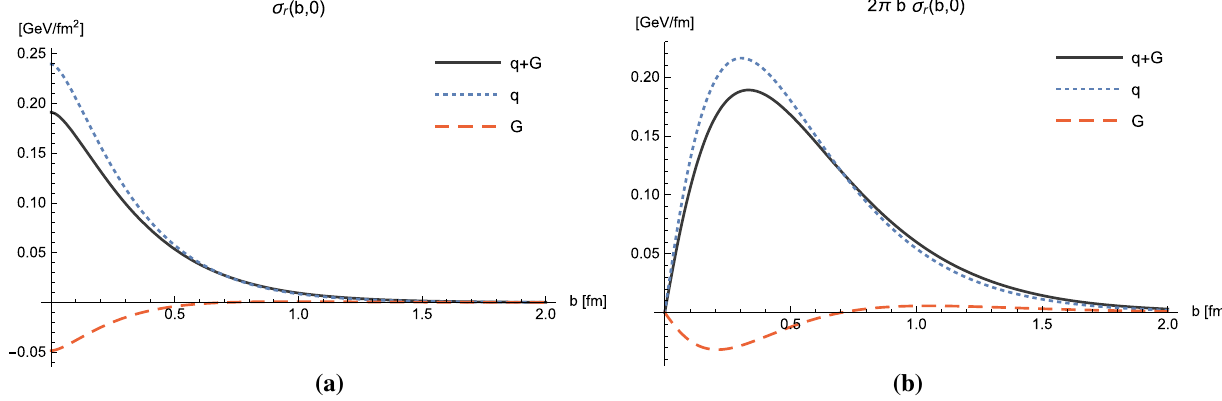
Fig. 12 Plots of the two-dimensional radial pressure, a σ r ( b , 0 ) and b 2 π b σ r ( b , 0 ) , using the multipole model (11) with parameters given in Table 1, see Eq. (57) or Eq. (62) for the definition in terms of GFFs